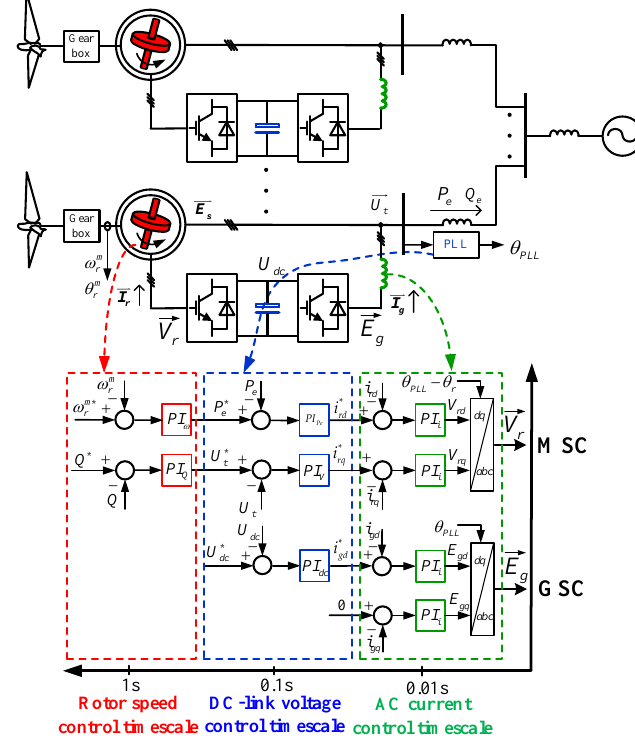
Figure 1. Multi timescale dynamics in DFIGs.